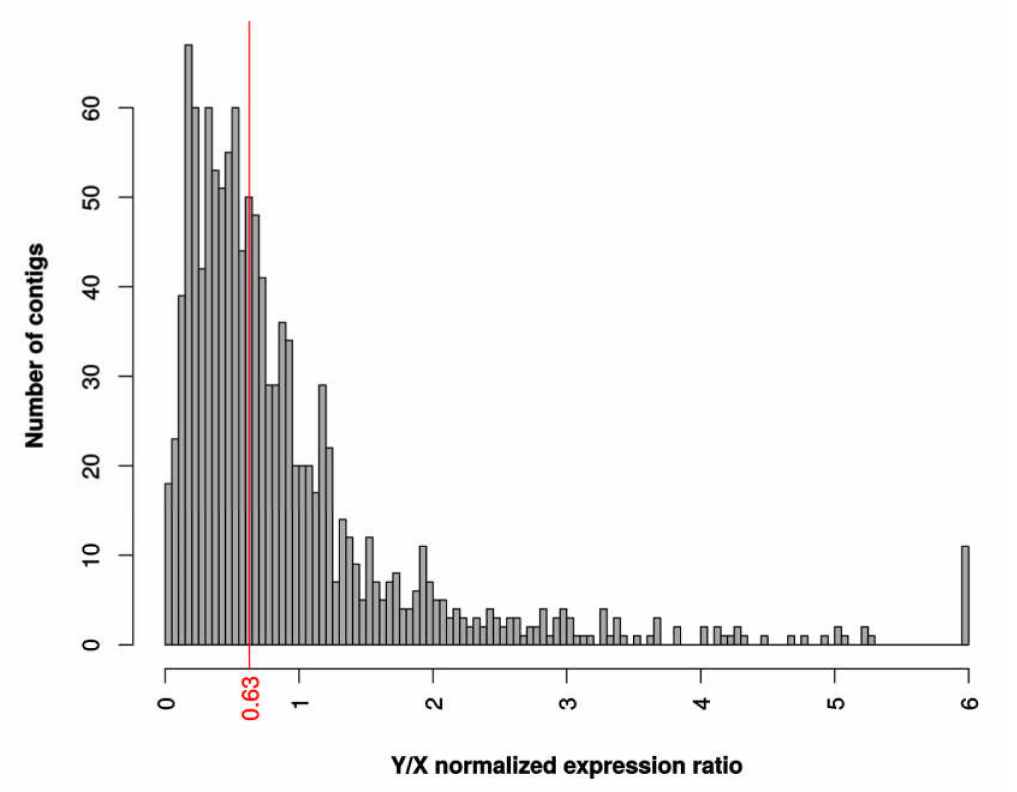
Figure 1. Y / X expression ratio in C. grandis . Distribution of normalized expression ratio between X and Y alleles. Total Y and X read numbers were summed at sex-linked SNP locations for each contig and normalized for each male separately, then averaged across males to obtain the Y / X ratio. The median is shown in